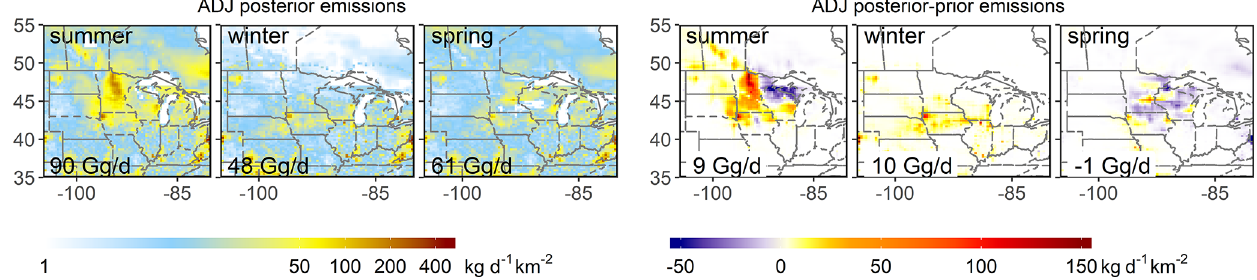
Figure 7. Methane emissions derived from the adjoint 4D-Var inversions with associated posterior–prior differences. Results are shown for GEM1 (July–August 2017), GEM2 (January 2018) and GEM3 (May–June 2018). GMM-ADJ results are similar (Figs.